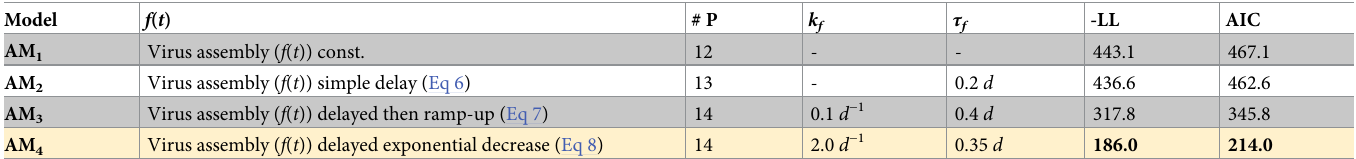
Table 5. Model comparison of the AM models. Negative log likelihood (-LL), AICs and number of estimated model parameters (#P) of the assembly models (AM) with- out exosome secretion. AM 1 to AM 4 were each fitted to plus-strand RNA, minus-strand RNA, intracellular and extracellular virus from Keum et al. [35]. The model with the lowest AIC is highlighted in beige.